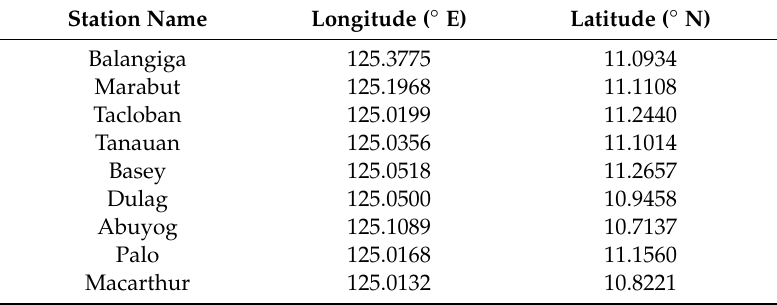
Figure 2. ( a ) The water depths over the computational domain. The color shading indicates the water depth in m. The dashed black line depicts the contour line of the 30 m water depth. ( b ) A map for the numerical gauges set up in the storm surge model (solid green circles) and the Guiuan weather station (solid red circle). The numerical gauges can be found in Table 2. Table 2. Locations of the numerical gauges setting in the storm surge model.